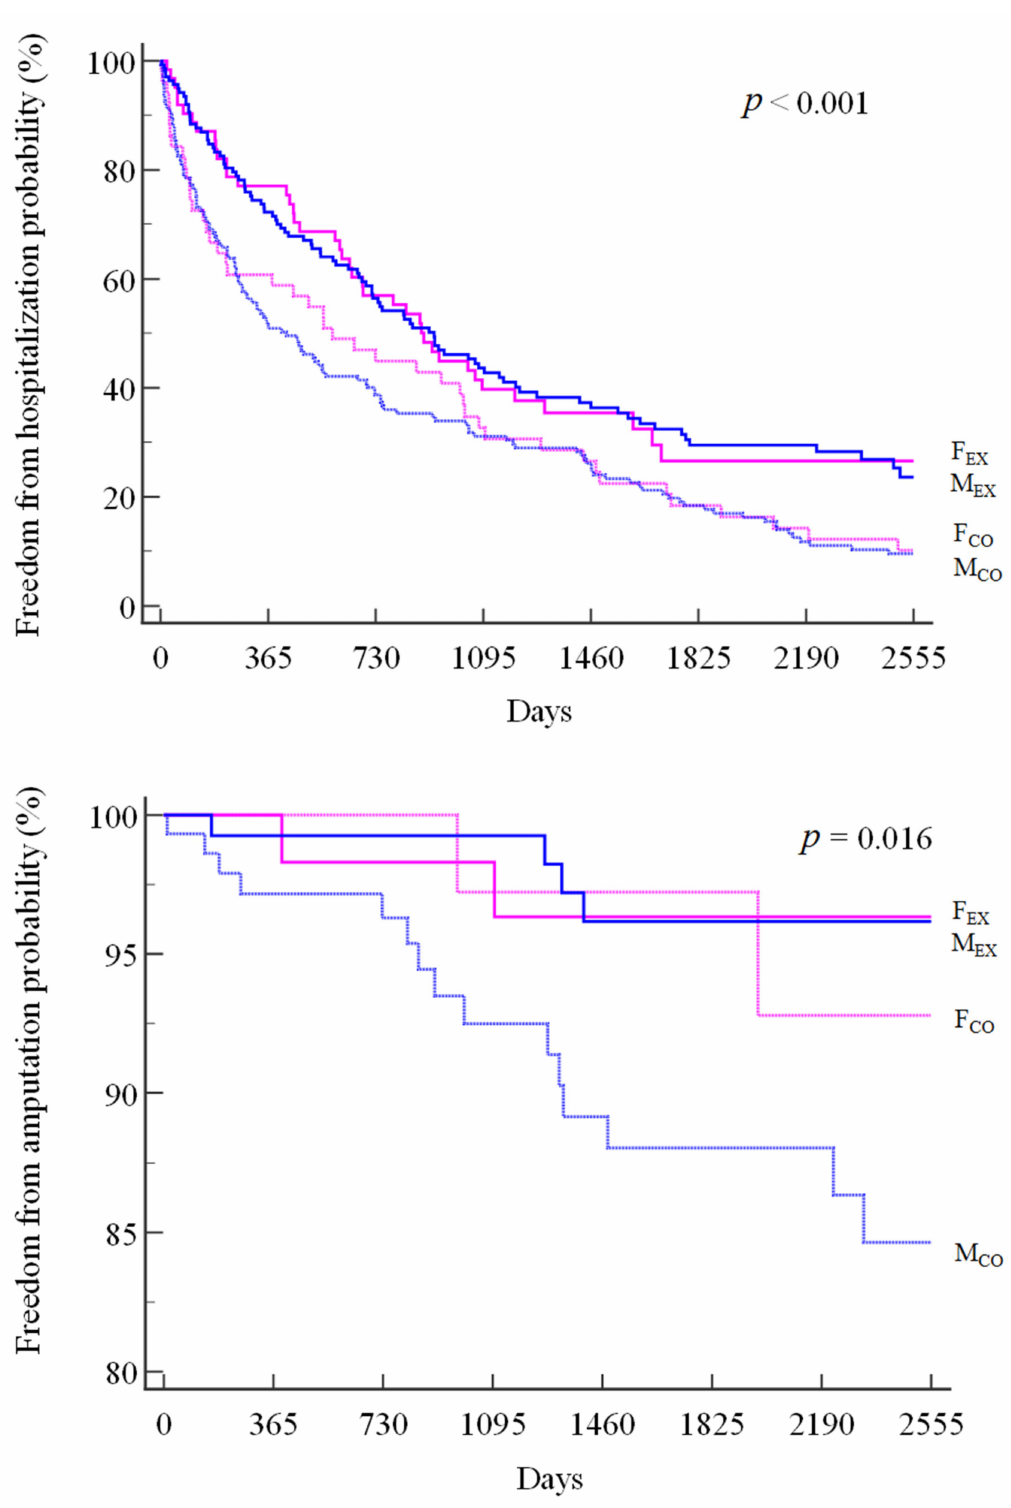
Figure 2. Kaplan-Meier curves of all-cause hospitalizations (top panel) and amputations (bottom panel) in the four